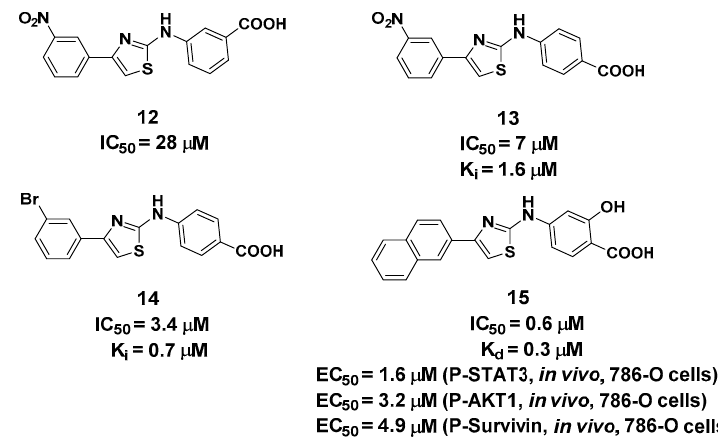
Figure 6. Structure and biological activity of 2-aminothiazole derivatives (Ki, Kd and IC 50 values tested in vitro).